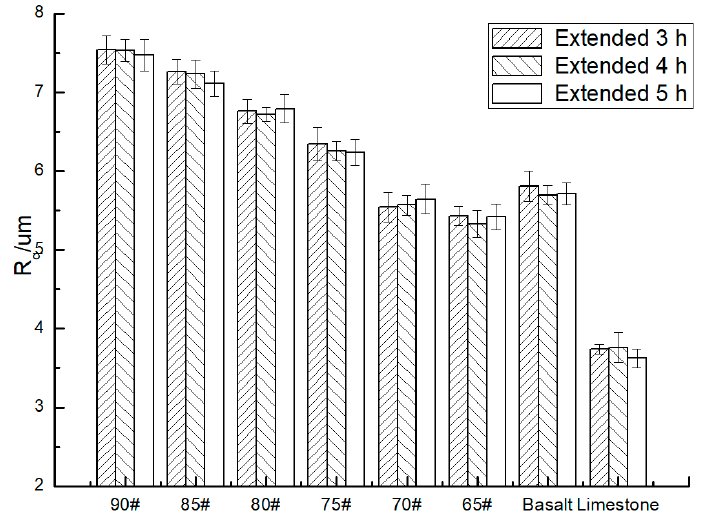
Figure 13. The value of R q after the extended 3 h, 4 h, and 5 h polishing times.